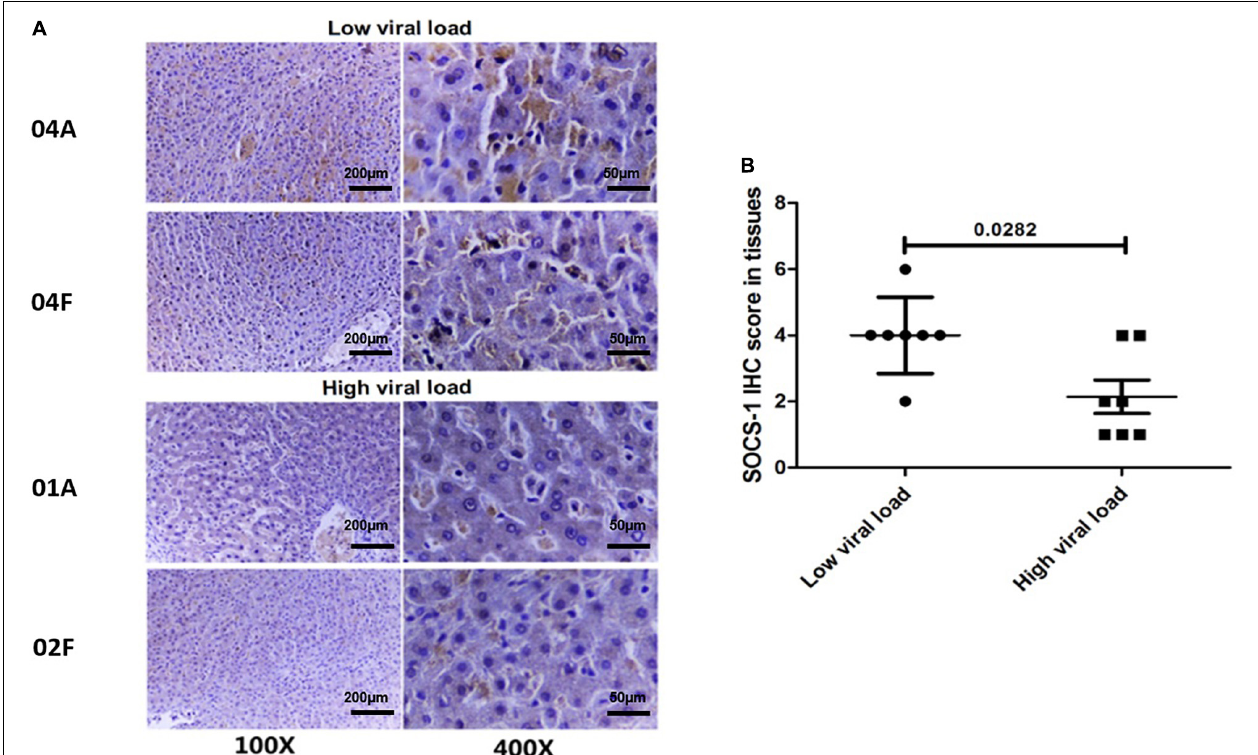
FIGURE 3 | Tissues with a high viral load exhibit a lower level of SOCS-1 expression when they have similar histological inflammation. (A) Representative images of SOCS-1 expression in adjacent and distal tissues with different viral loads. “04, 01, and 02” represent patients’ numbers. “A” represents adjacent tissues. “F” represents distal tissues (scale bar = 50 µ m in 400 × images, 200 µ m in 100 × images). (B) Axiotis score of SOCS-1 expression in adjacent and distal tissues with different viral loads (Wilcoxon paired test).